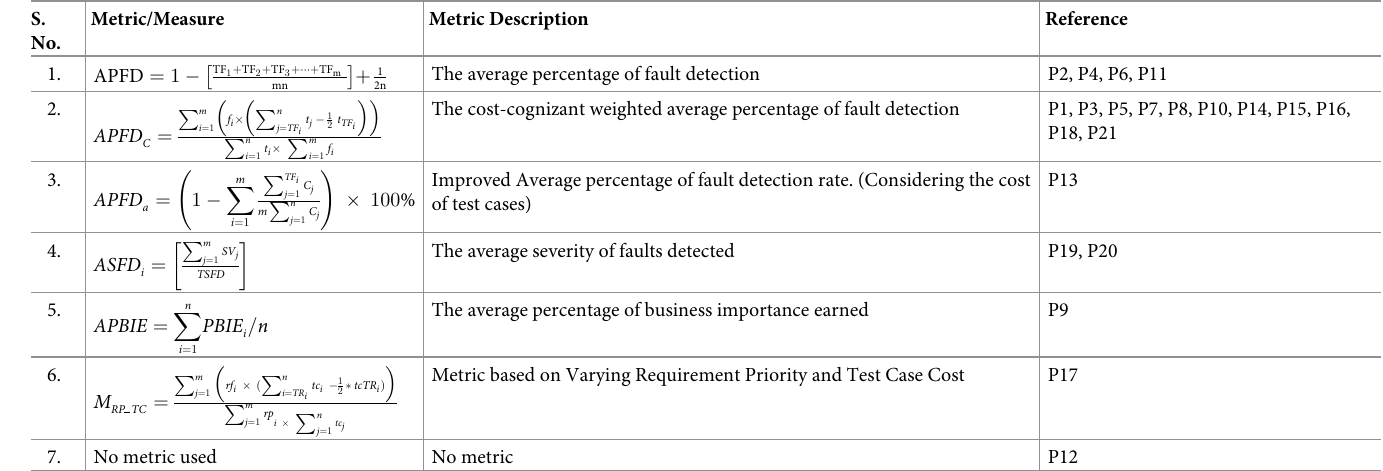
Table 10. Performance evaluation metrics used in cost-cognizant TCP.